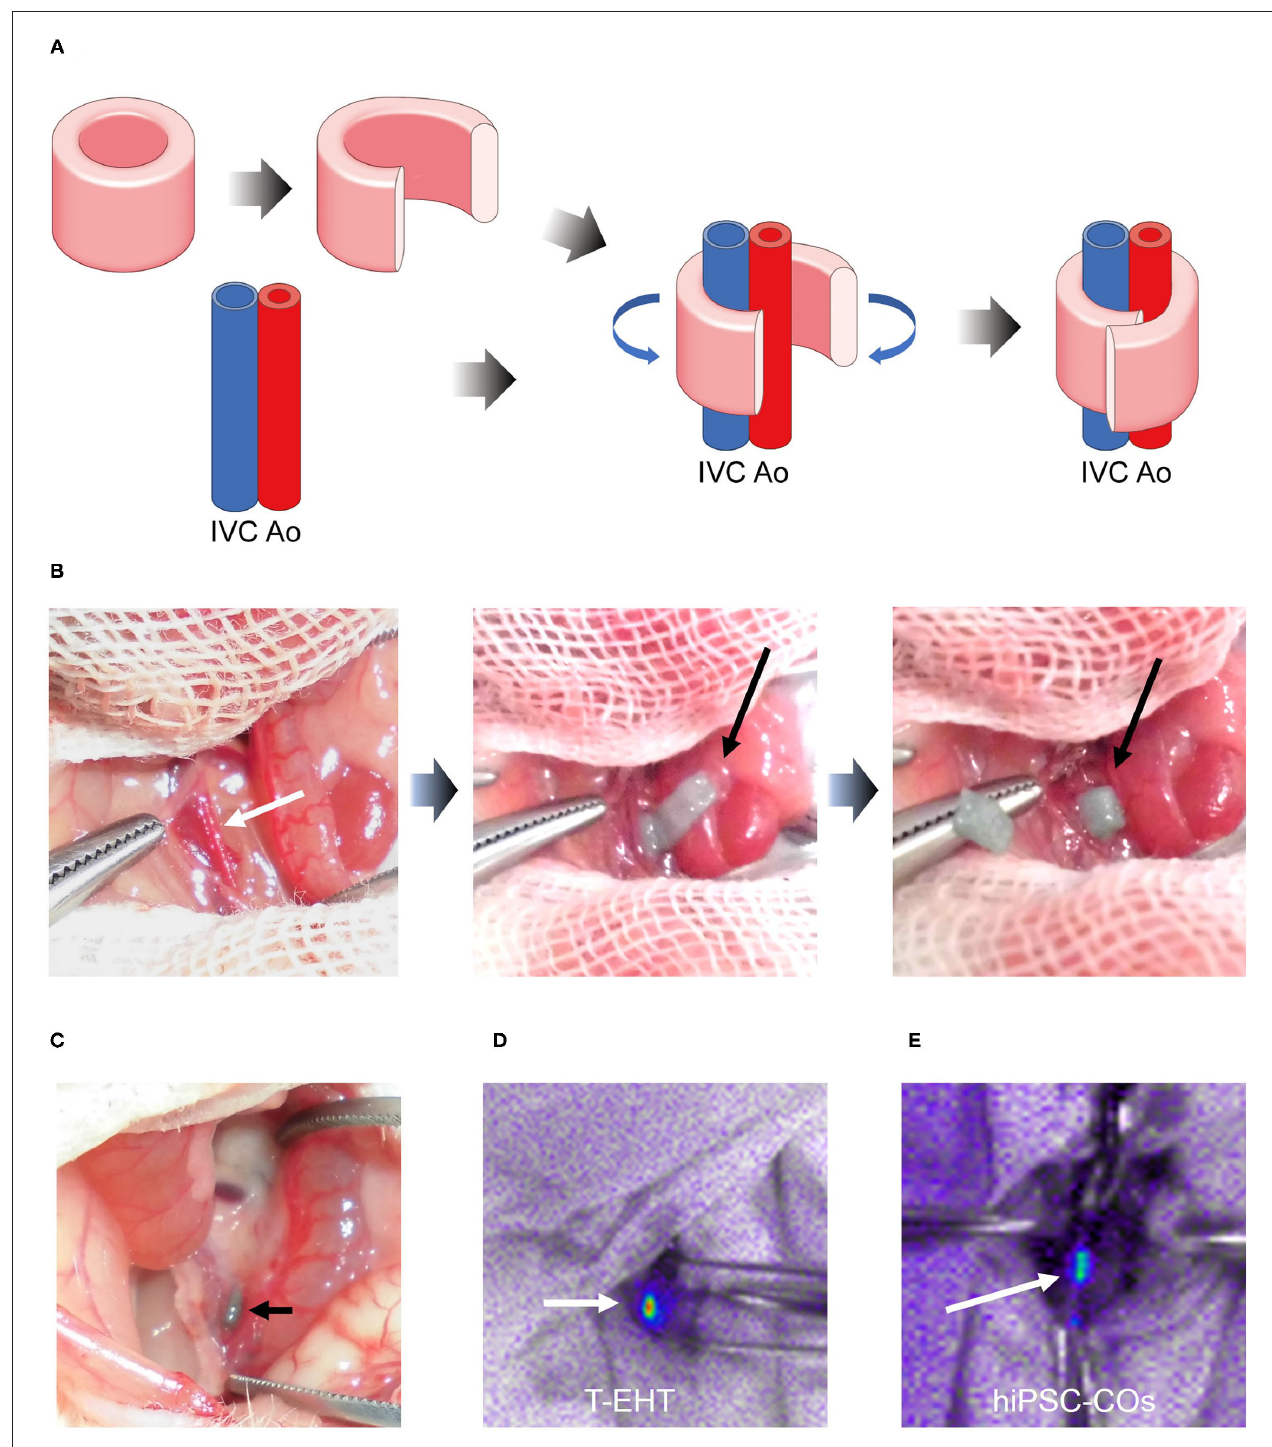
FIGURE 3 | Transplantation procedure and histological analysis of transplanted tubular engineered heart tissue (T-EHT). (A) Scheme of transplantation procedure. The T-EHT is removed from the needle array, cut open, and wrapped around the abdominal aorta and inferior vena cava (IVC). (B) Transplantation procedure. The abdomen of each NOG mouse is opened under general anesthesia. The aorta and IVC are exposed (white arrow) and the T-EHT (black arrow) is wrapped around them. (C) After 1w of transplantation. T-EHT (black arrow) is engrafted in the NOG mice. (D) and (E) Fluorescent images captured after 1w of transplantation. The T-EHT and hiPSC-COs were labeled with far-red before transplantation (white arrows). Engrafted tissues with far-red fluorescence were visualized using Nightowl.